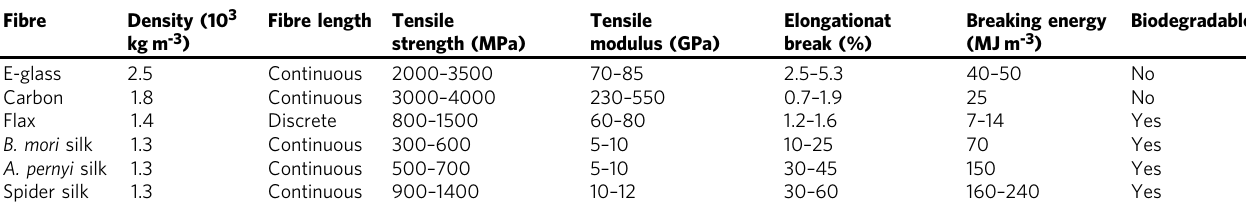
Table 1 Comparison of the physical, mechanical and economic properties of different fi bres 8,9,51